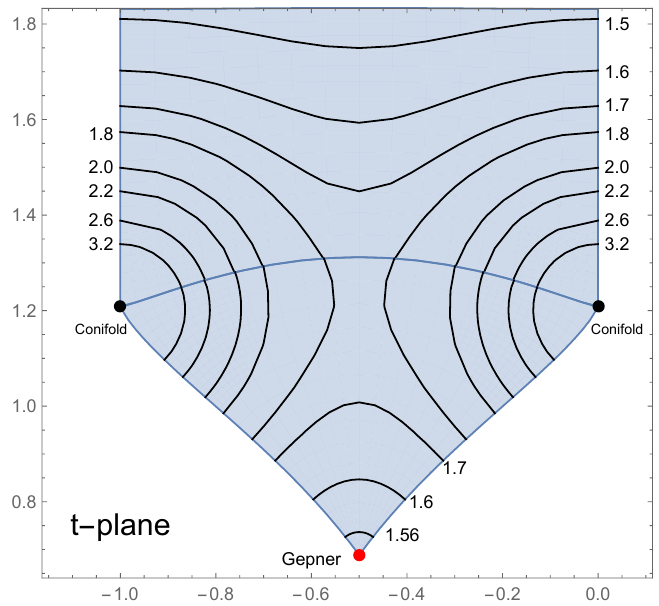
Figure 14. The contour plot for the chiral ring coe(cid:14)cient (cid:21) of the K(cid:127)ahler modulus for the quintic in the t -coordinates. The blue shaded region is the K(cid:127)ahler moduli space of the quintic. The M black curves are the constant (cid:21) loci, with the values of (cid:21) indicated at the ends of the curves. The blue curve in the middle corresponds to = 1, with two ends being the conifold point = 1. The j j Gepner point = 0 is shown in